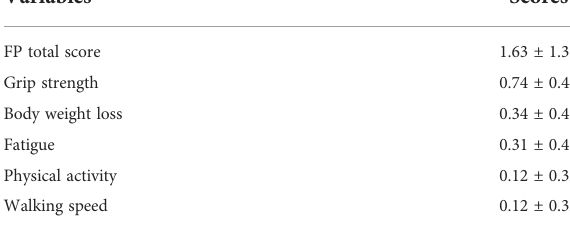
TABLE 1 Frailty Phenotype score in lung cancer patients with chemotherapy